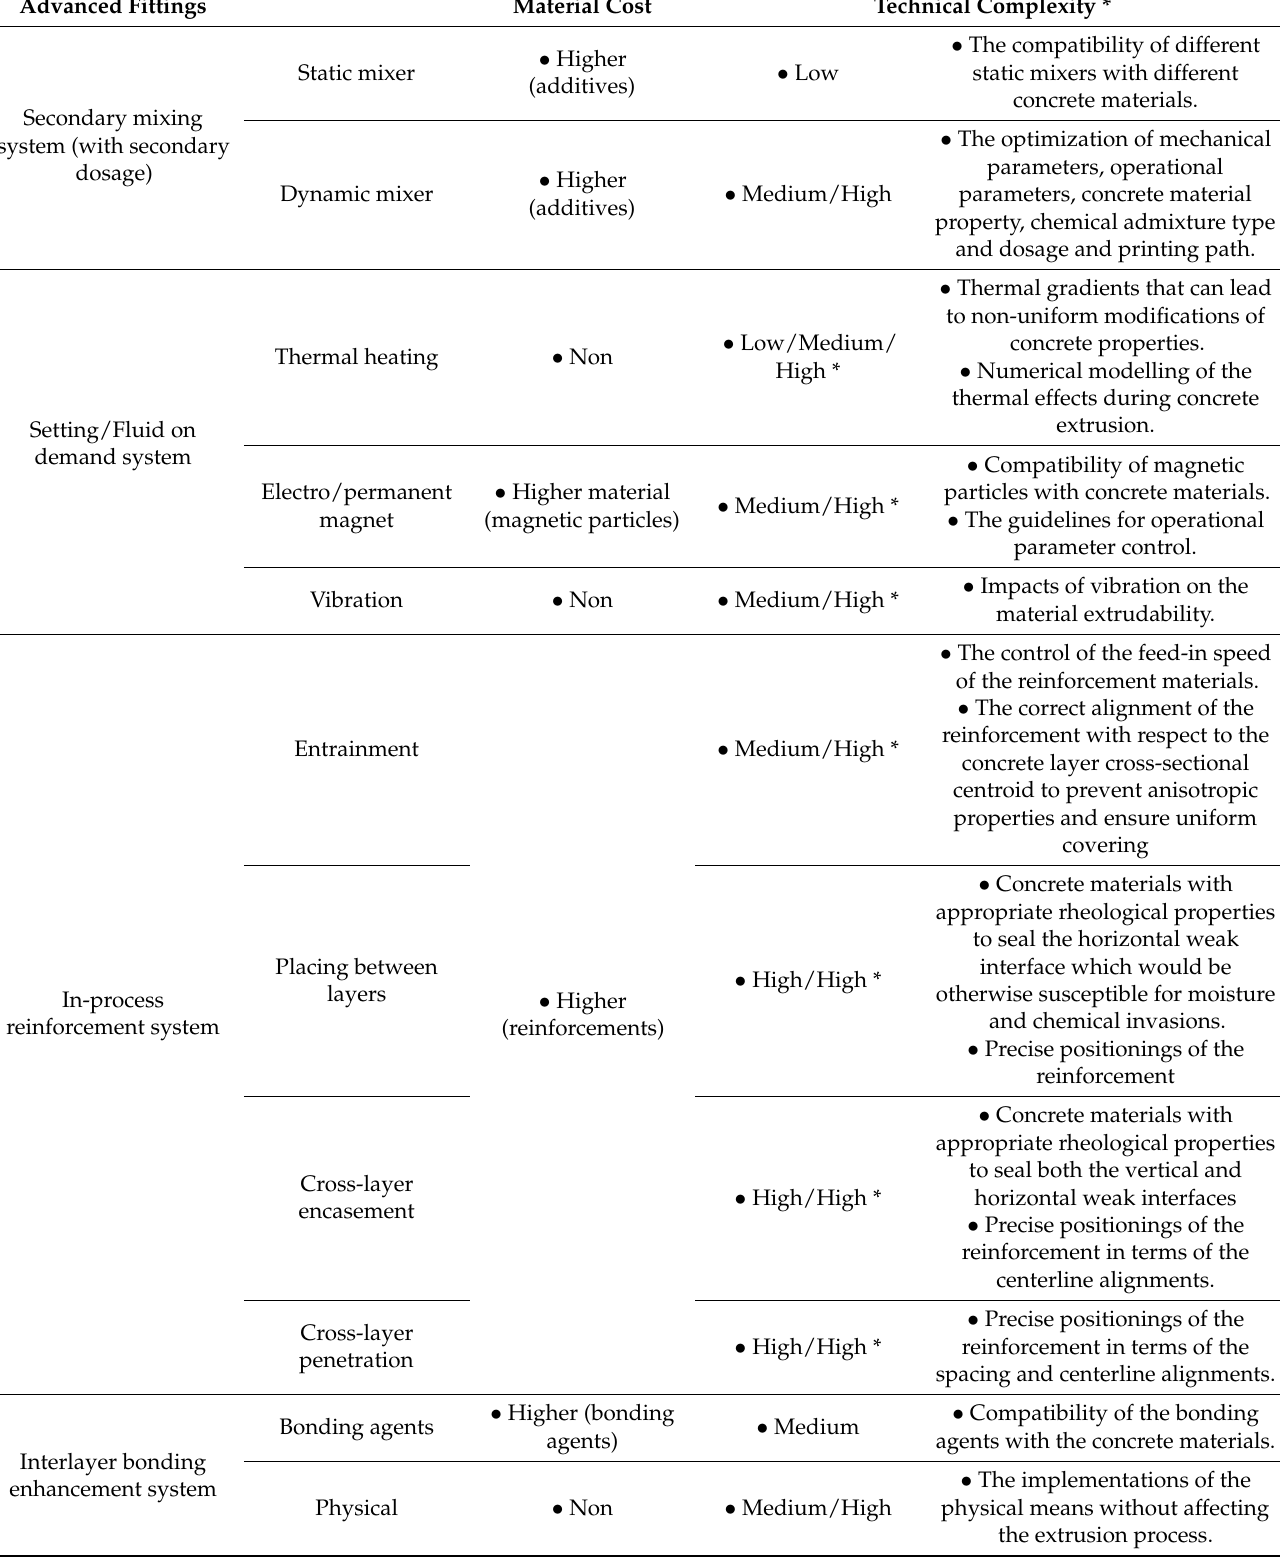
Table 8. The material costs and technical complexity of the advanced